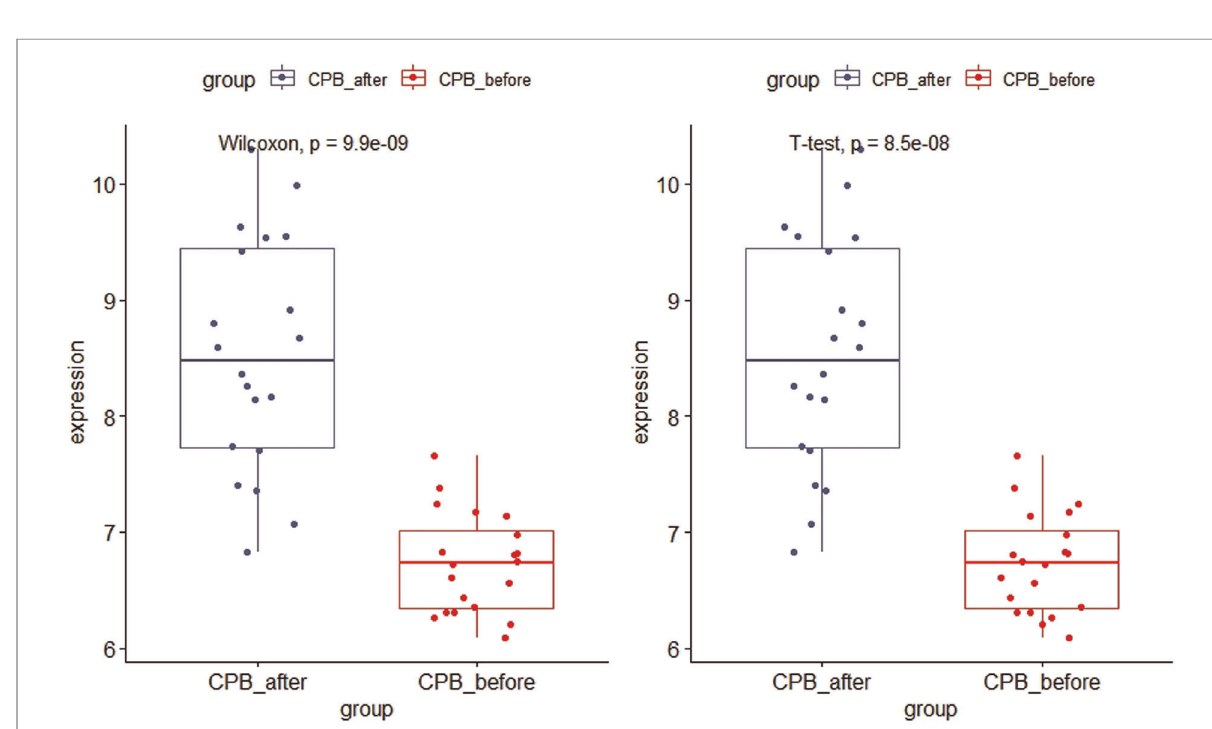
FIGURE 12 Box plots of CDKN1A gene expression in the GSE 132176 dataset. The expression of CDKN1A was signi fi cantly lower in the pre-CPB group than in the post-CPB group (Wilcoxon, P =9.9×10 − 9 ; T-test, P =8.5×10 − 9